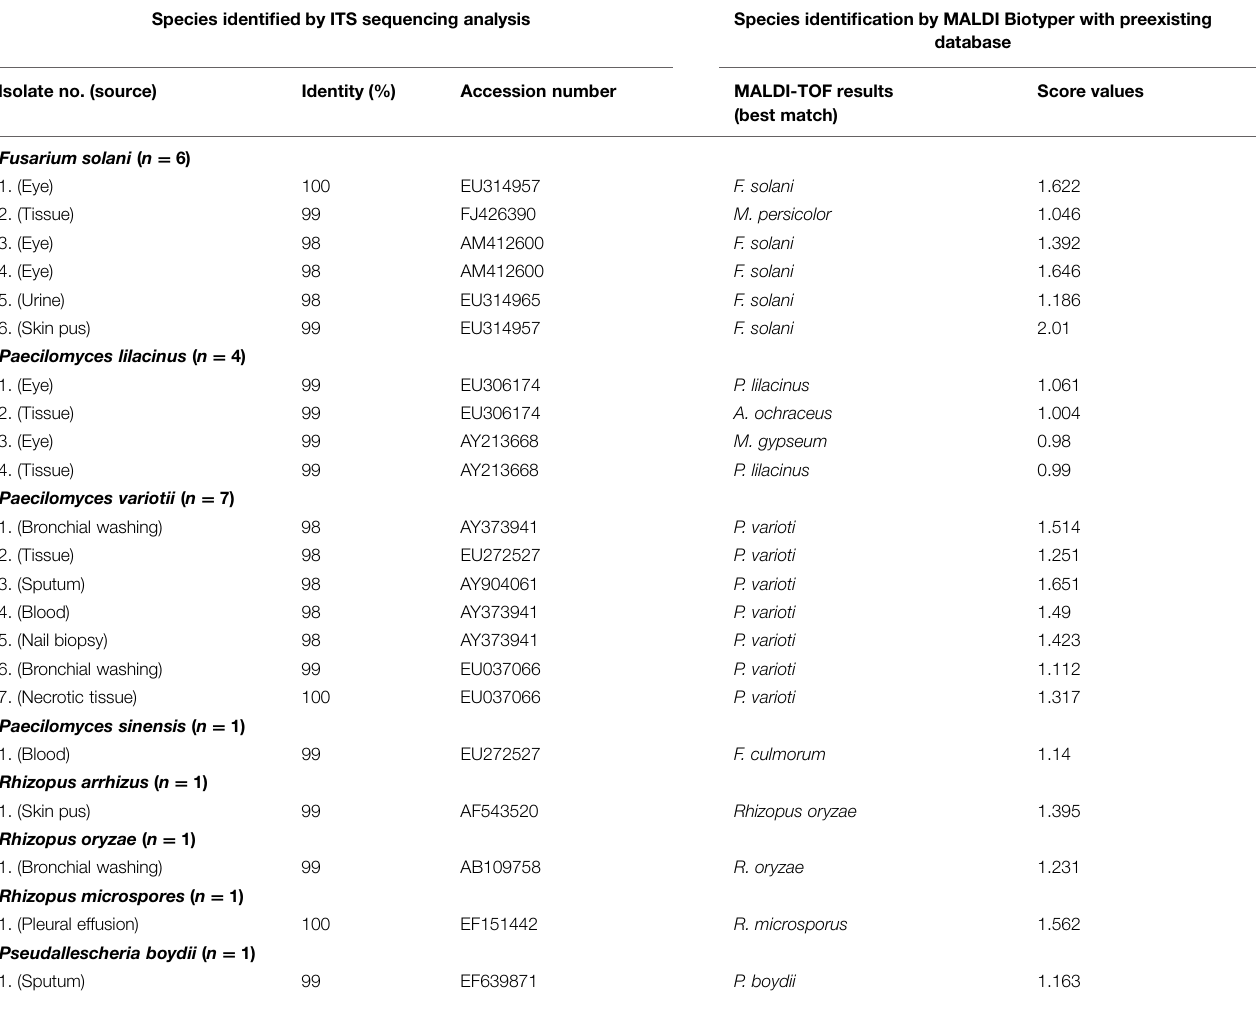
TABLE 2 | Comparison of identification results by the MALDI Biotyper system with those of molecular method in identifying 22 non- P. marneffei isolates of molds. Species identified by ITS sequencing